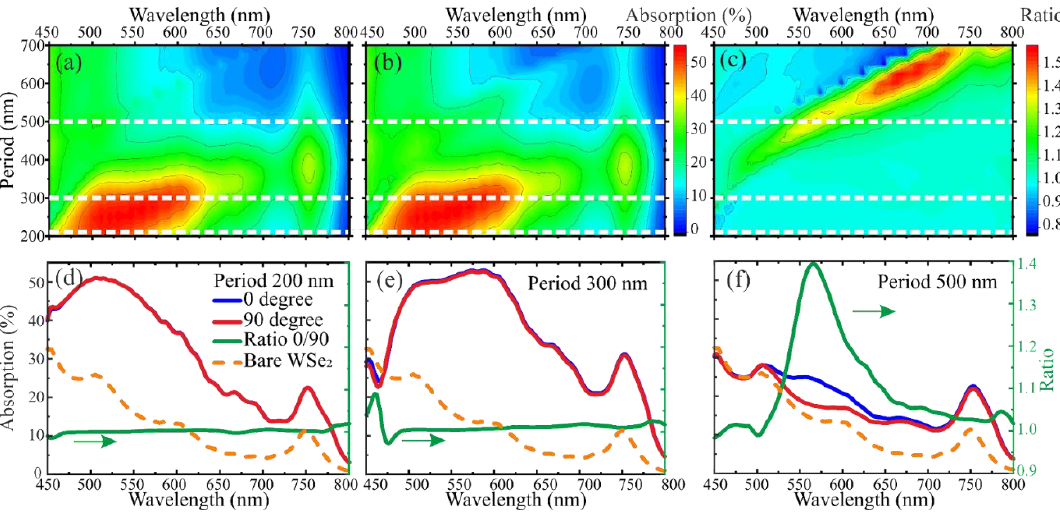
Figure 6. Simulation results of the optical absorption dependence in a two-dimensional WSe 2 film on the plasmonic structure period and the incident radiation wavelength with ( a ) φ = 0° and ( b ) φ = 90°. ( c ) The absorption ratio at φ = 0° to φ = 90°. Dependence of optical absorption for different azimuthal angles of incident polarization at ( d ) T = 200 nm, ( e ) T = 300 nm, and ( f ) T = 500 nm.